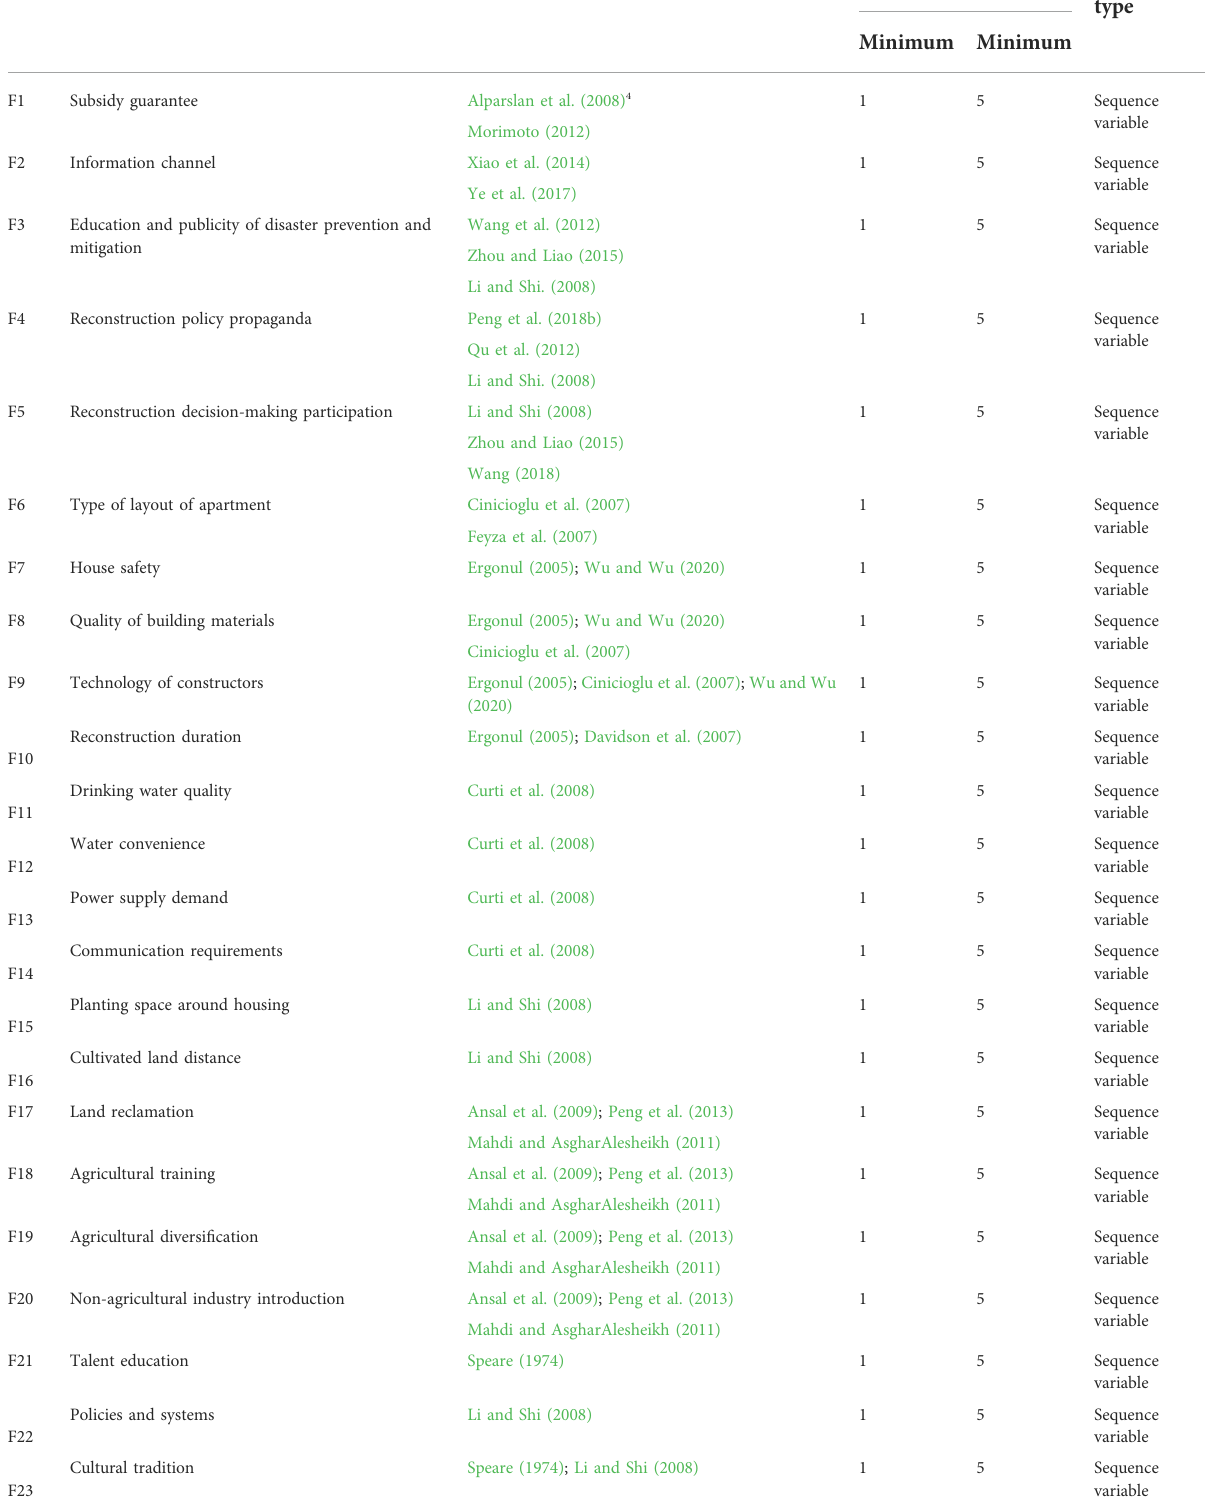
TABLE 3 Post-disaster reconstruction satisfaction survey scale